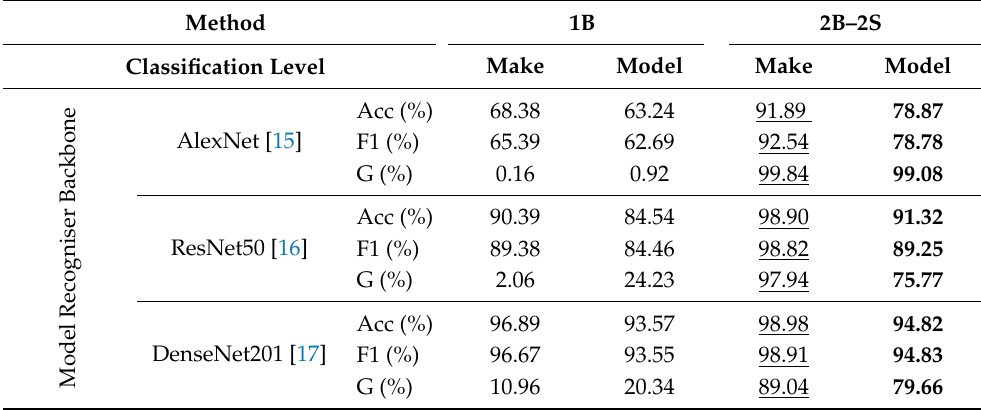
Table 6. VMMR results over Compcar-51